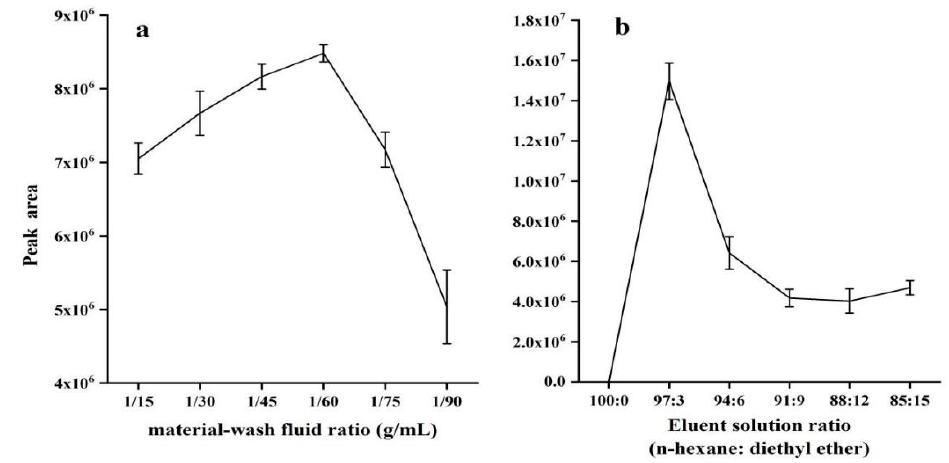
Figure 2. Influence of two parameters on Purification efficiency: ( a ) material-wash fluid ratio and ( b ) elution solution ratio. elution solution